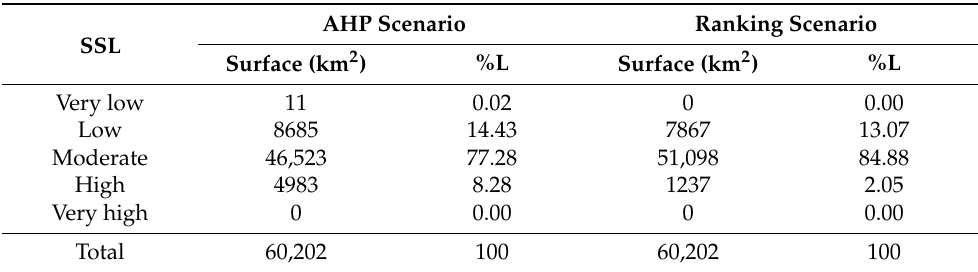
Table 10. Surface area corresponding to five site-suitability levels for the development of solar farms in the Desert of Chihuahua under the AHP and ranking